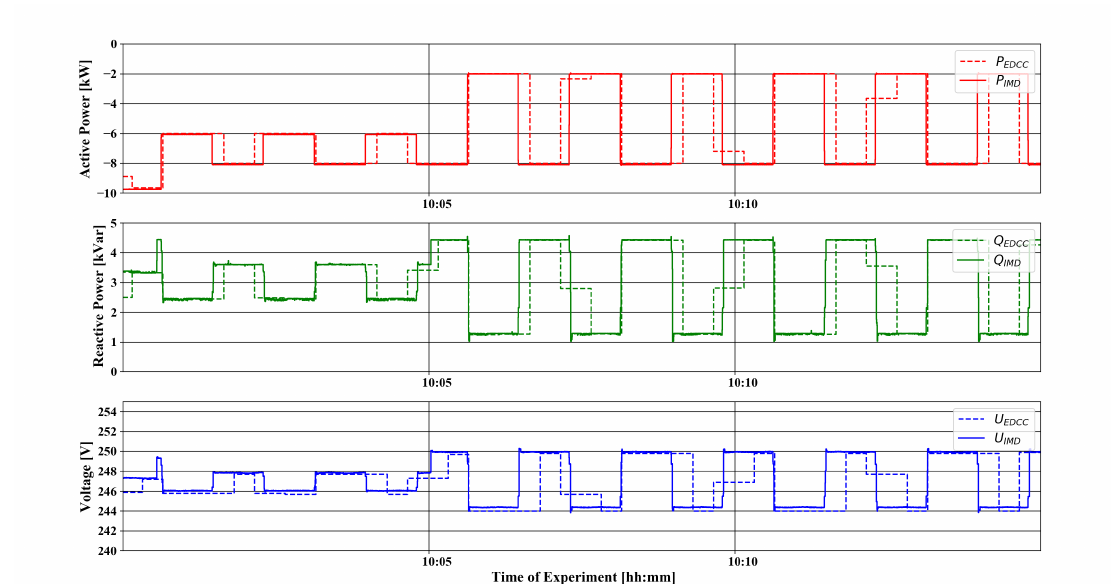
Figure 15. Transmitted Readings (EDCC) and independent measurements (IMD) for a time period with activated P(U) control